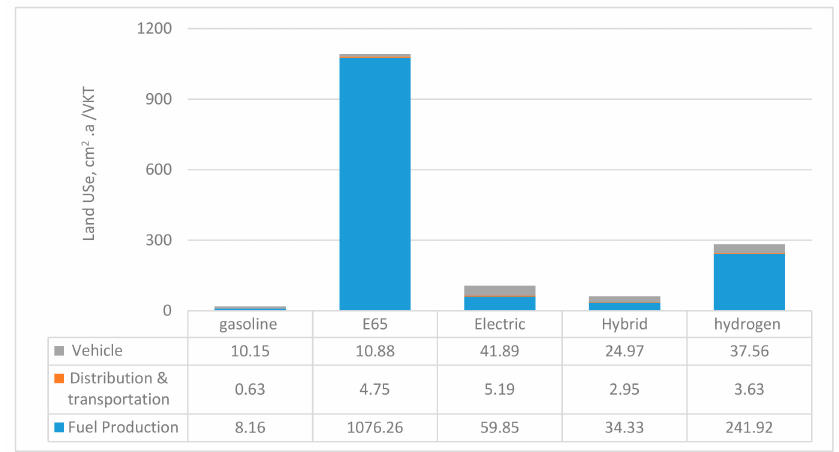
Figure 7. Land use impact for di ff erent fuel options (tailpipe emission is omitted as there is no land use impact associated with tailpipe